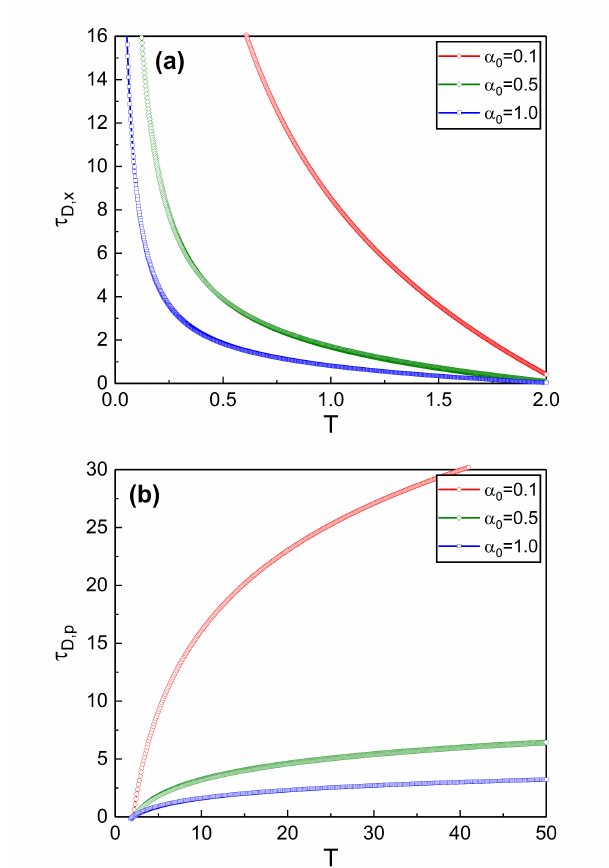
Figure 3. Decoherence time τ D , x ( a ) given in Equation (77) and τ D , p ( b ) in Equation (79) for the damped harmonic oscillator plotted as a function of T . The values taken here are given by ¯ h = 1, k = 1, Ω 0 = 1, m 0 = 1, x − x (cid:48) = 1, p − p (cid:48) = 1, and ϕ =